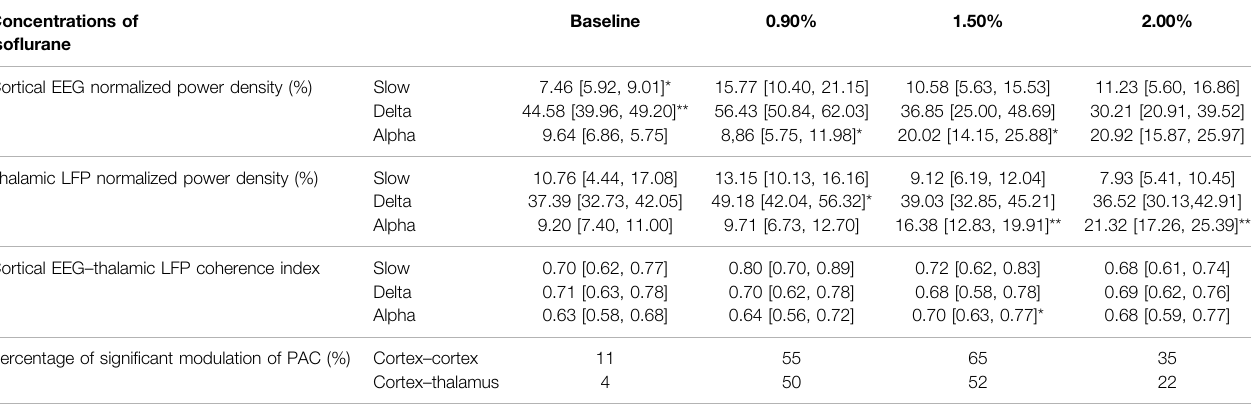
TABLE 1 | Results of cortical EEG and thalamic LFP analysis. Concentrations of iso fl